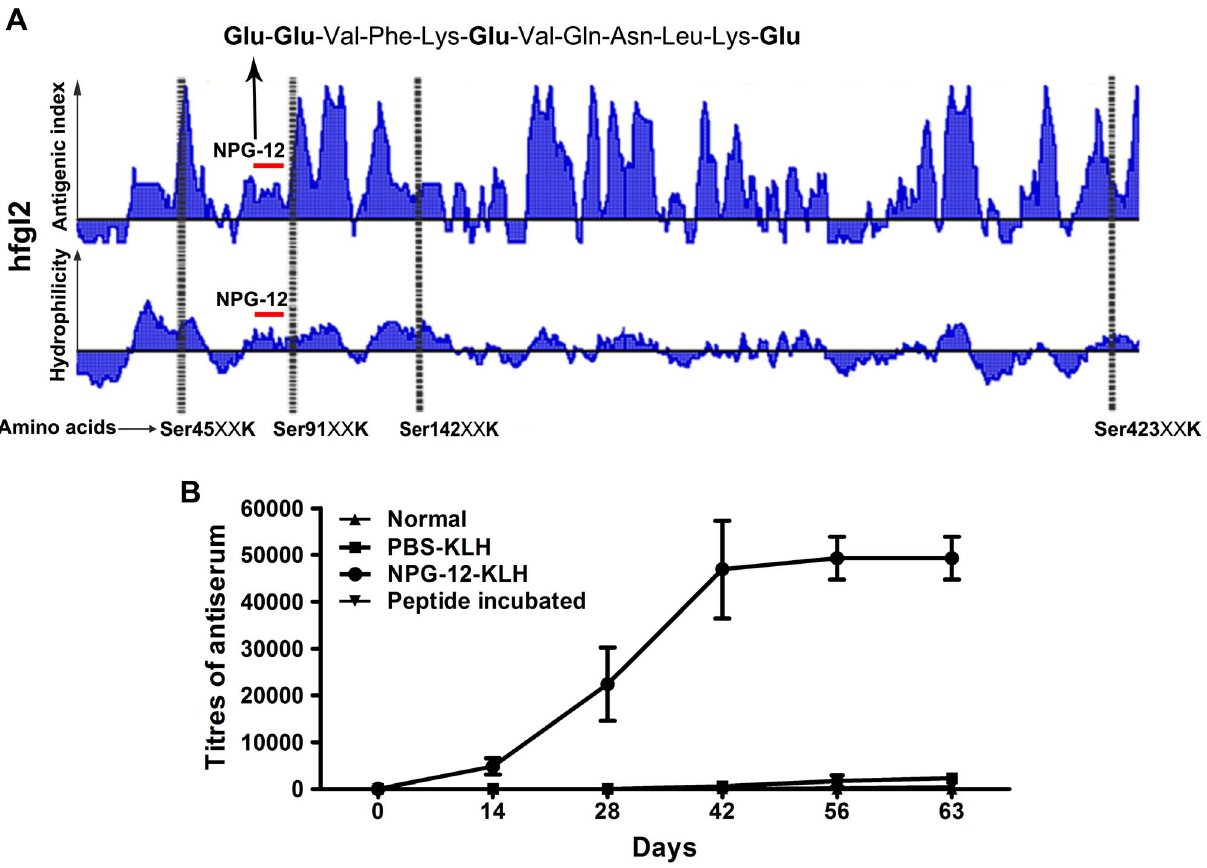
Figure 2. NPG-12 peptide selection and generation of anti-NPG-12 antibodies. (A) hfgl2 antigenic index (Jameson-Wolf) and hydrophilicity plot (Hopp-Woods) analysis. Four serine peptidase Clan E catalyzing sites (SXXK motifs) were identified. The target peptide NPG-12 mapped to positions 76 to 87 near Ser91XXK is indicated by a red bar. (B) The titer of the anti-NPG-12 antibodies were increased to its peak in the NPG-12-KLH group after the third immunization, whereas no detectable titer was found in the normal and the PBS-KLH and peptide-pre-incubated groups, as determined by ELISA. Peptide incubated: peptide NPG-12 pre-incubated with anti-NPG-12 antisera group.